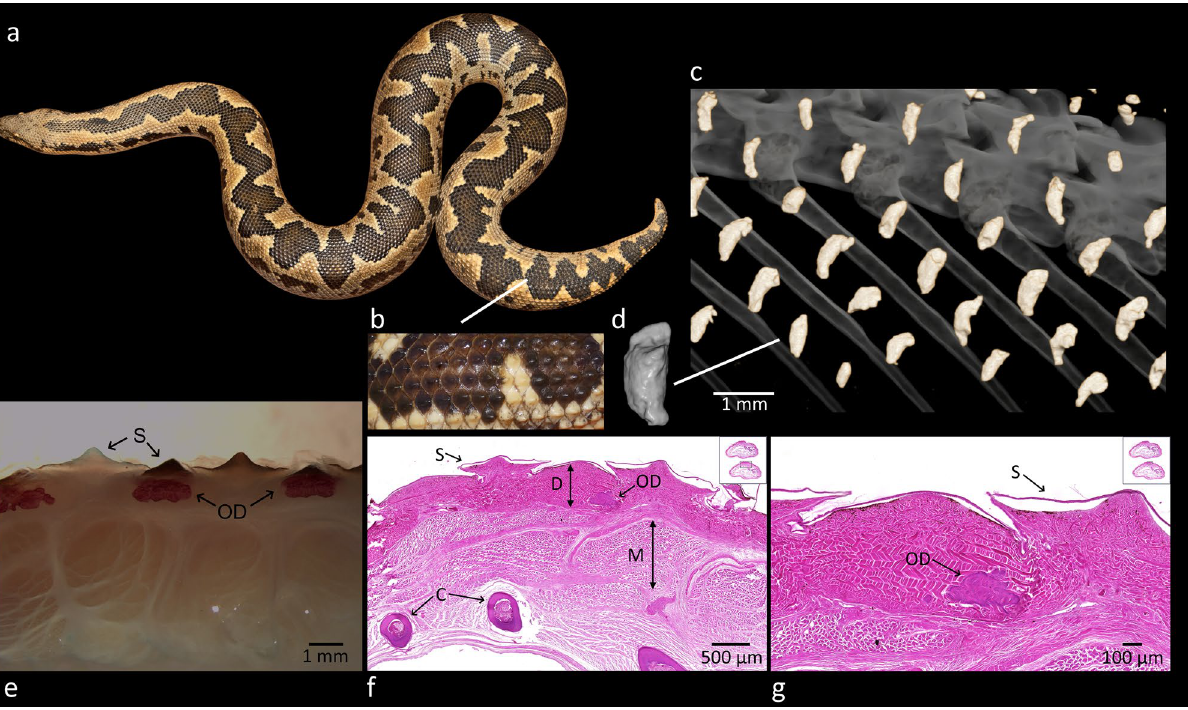
Figure 1. Structure and composition of the osteoderms of Rough-tailed sand boa ( Eryx conicus ). ( a ) Whole- body photo of a “two-headed” snake; ( b ) the detail of rough scales on the top of the tail; ( c ) reconstructed µCT scan of lateral dermal armour and axial skeleton with ribs; ( d ) the detail of osteoderm; ( e ) osteoderms from the lateral dermis of the caudal part of the body prepared as a whole-mount using Alizarin red (single-stained); ( f ) transverse section (dorsal towards the top) of the caudal part of the body stained by haematoxylin and eosin; ( g ) the detail of osteoderm from transverse section of the caudal part of the body stained by haematoxylin and eosin. Note in ( c ) vermiform-like osteoderms (yellow), while the axial skeleton and ribs are grey. Osteoderms in ( e ) resides entirely within the pars papillaris corii closely below the squama. The origin of our samples (private collections of animals died of natural causes) prevents us to preserve the tissue for fine histology. The nuclei in ( f , g ) are not visible because they were already degraded. OD (osteoderm), C (costae), D (dermis), M (musculus), S (squama). Author: Petra Frýdlová, Jan Dudák, Milada Halašková, Markéta Riegerová and Daniel